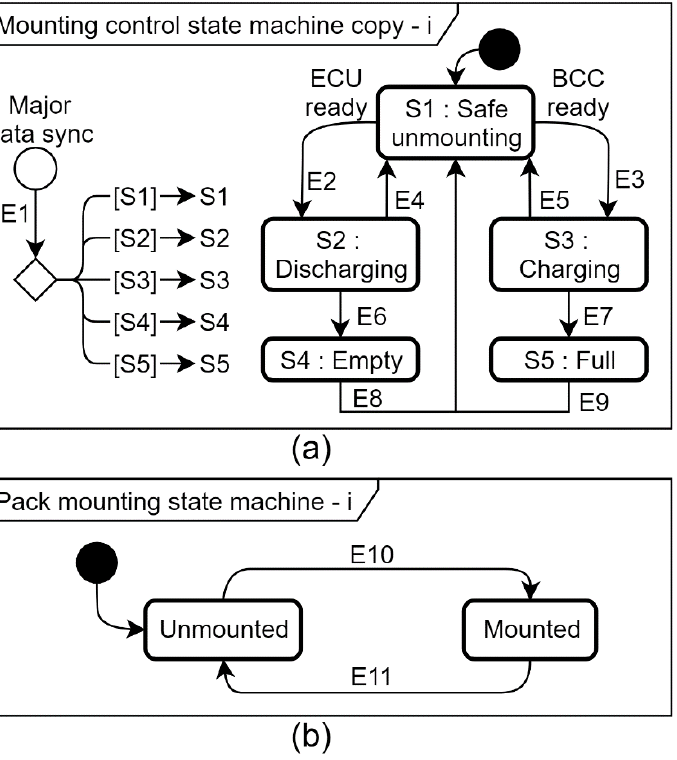
Figure 5. ( a ) i -th slot copy of the battery power network mounting control state machine. ( b ) Pack mounting state machine of the i -th slot.